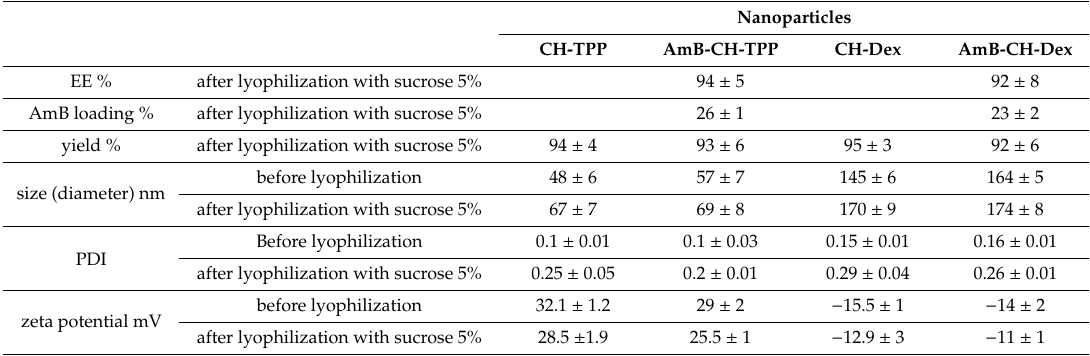
Table 1. Physicochemical properties of blank and amphotericin B (AmB)-loaded chitosan nanoparticles.